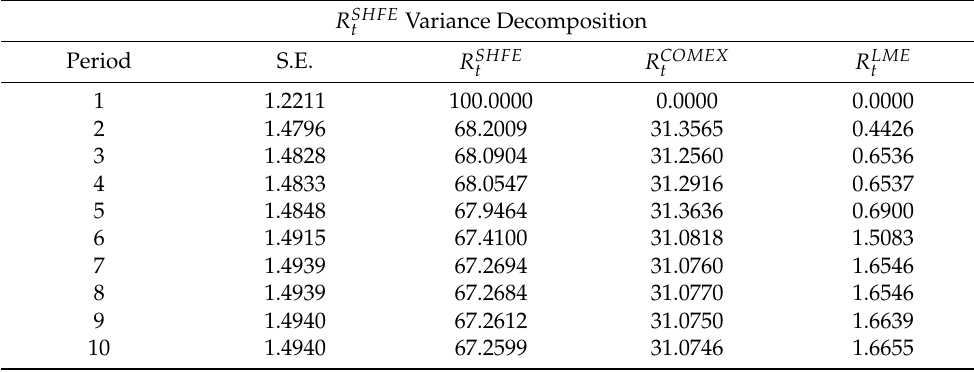
Table 6. Variance decomposition of copper returns in three markets in the second